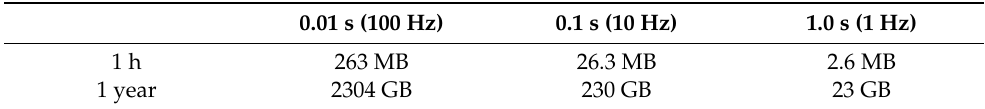
Table 1. Required storage space for the data from 36 sensors for a period of 1 h and 1 year depending on the sampling rate.